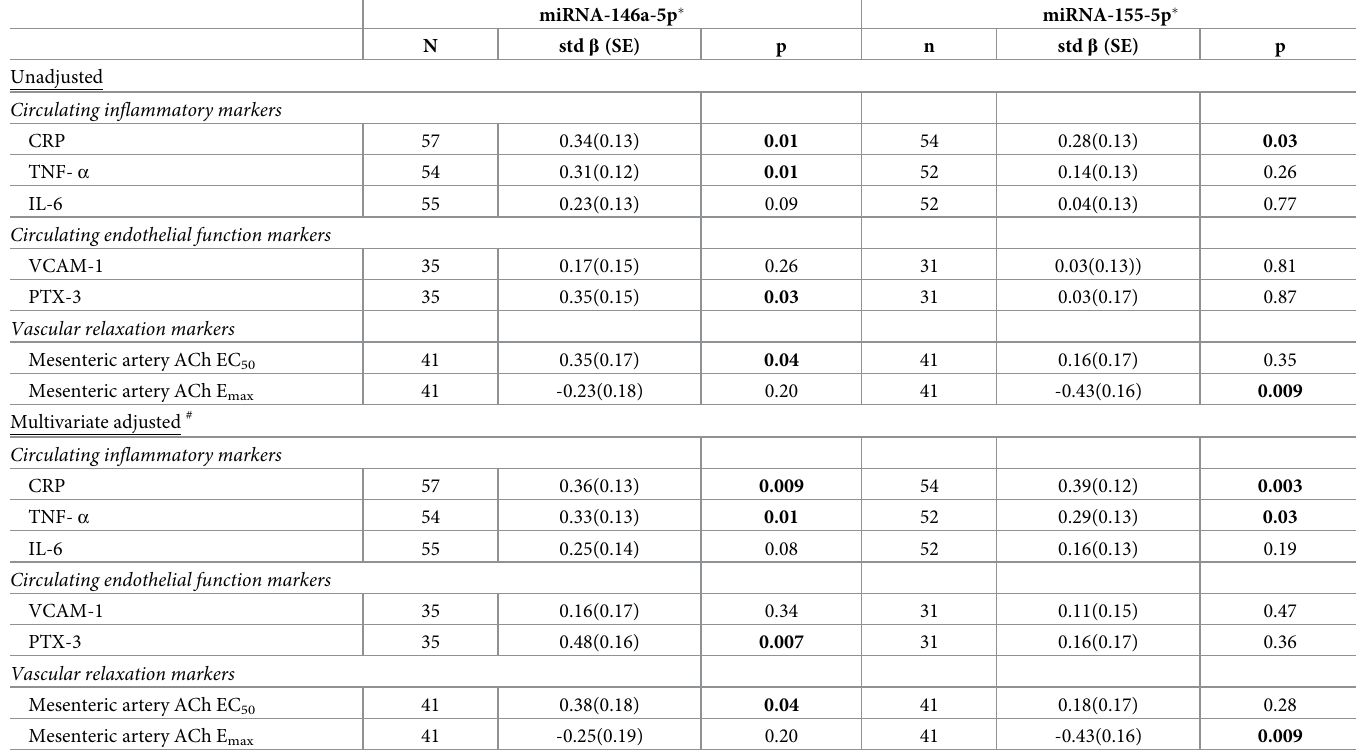
Table 2. Associations between relative microRNA expressions and markers of inflammation, endothelial function and vascular